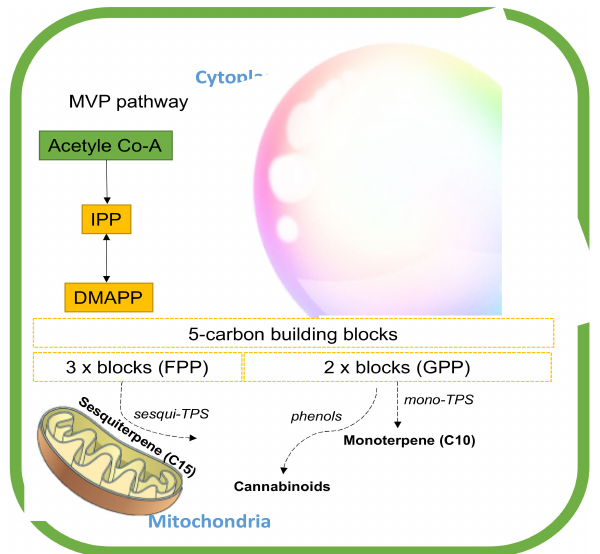
Figure 6. The terpene biosynthesis pathway in cannabis. Abbreviations: DMAPP, dimethylallyl diphosphate; FPP, farnesyl diphosphate; IPP, isopentenyl diphosphate; GPP, geranyl diphosphate; mono-TPS, monoterpene synthase; sesqui-TPS, sesqiterpene